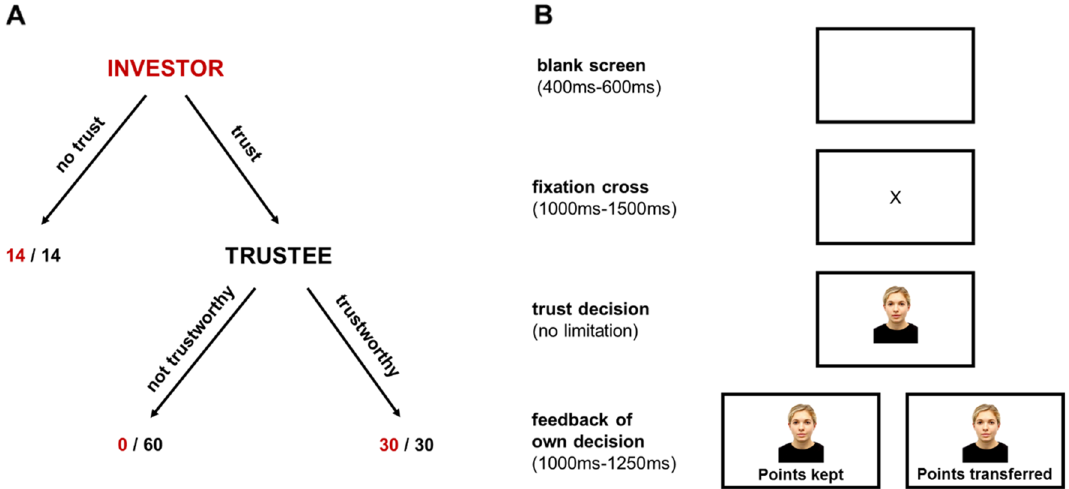
Figure 3. Modified version of the trust game. ( A ) Payoff structure. Participants were assigned the role of the investor. If the investor decided not to trust the trustee, both investor and trustee received 14 MUs. If the investor decided to trust, the trustee could either keep everything for him/herself (0/60) or transfer half of the points back to the investor (30/30). ( B ) Example trial with screen durations in milliseconds (ms). First, participants saw a blank screen for 400–600 ms, followed by fixation cross for 1000–1500 ms. Then, participants saw a photo of the trustee until they made their decision, which was then displayed for 1000–1250